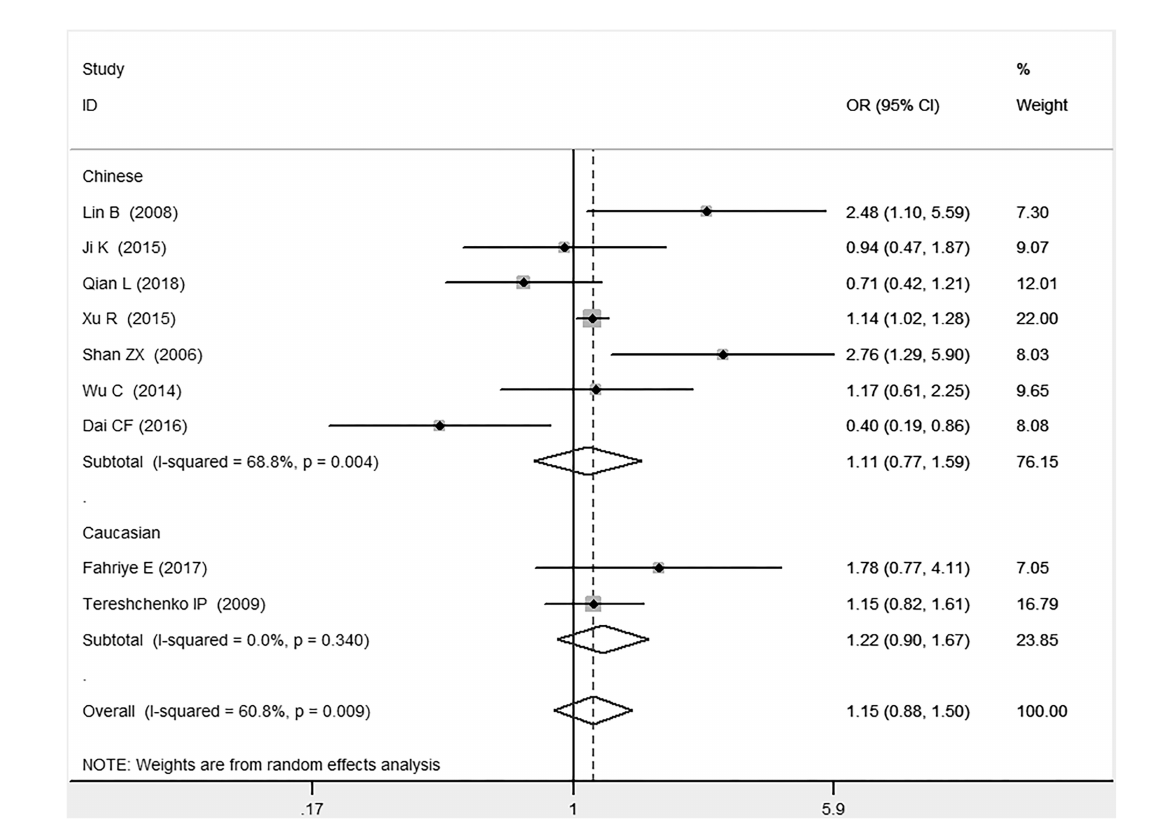
FIGURE4 Forest plot of CAD associated with MIF gene rs755622 G/C polymorphism under a heterozygous genetic model (i.e., GC vs. GG of MIF gene rs755622 G/C